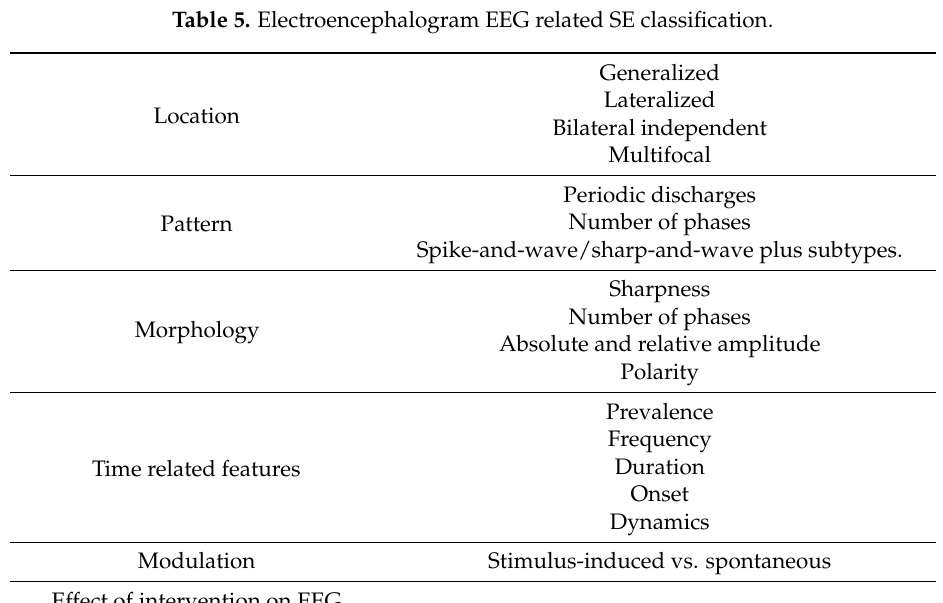
Table 5. Electroencephalogram EEG related SE